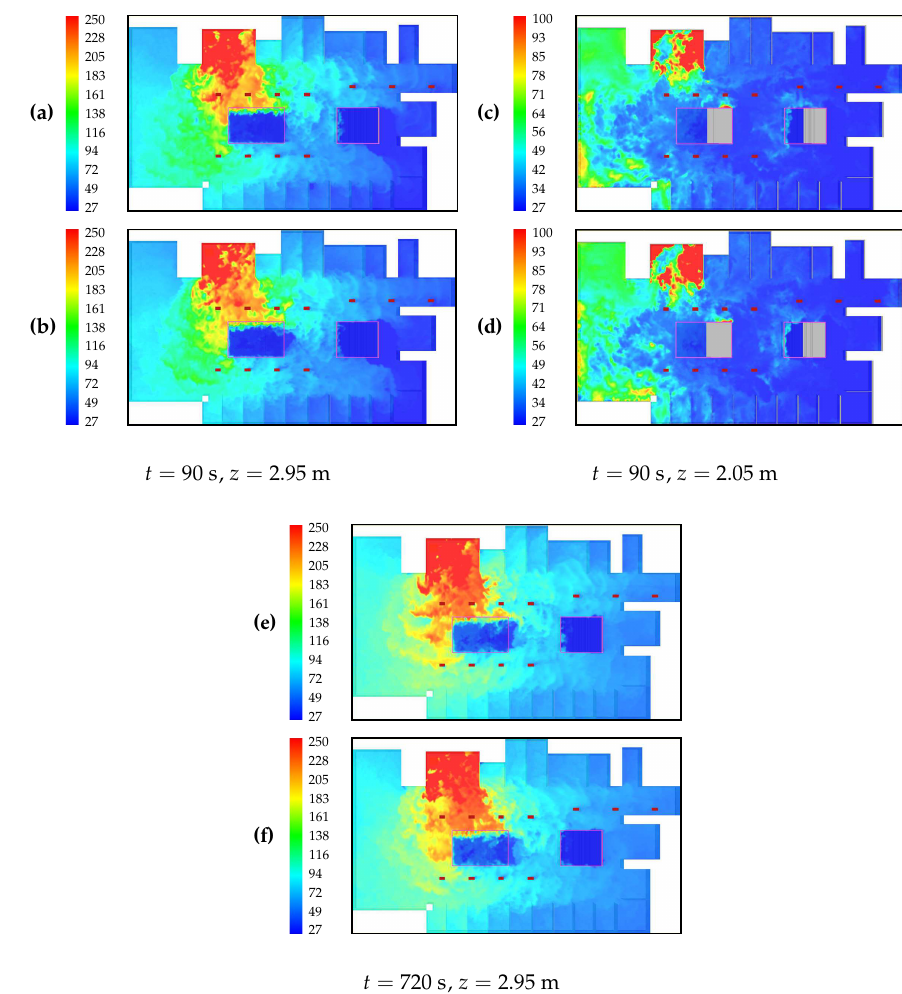
Figure 4. Temperature contours ( ◦ C) at instant t = 90 s and z = 2.95 and 2.05 m (top pictures), and at t = 720 s and z = 2.95 m (bottom pictures). Results obtained with FDS, a grid with L / δ the simplified fire model with ( a ) T in = 2436 K, ( b ) T in = 1500 K, ( c ) T in = 2436 K, ( d ) T in = 1500 K, ( e ) T in = 2436 K and ( f ) T in = 1500 K (cases G-1 and G-4 in Table